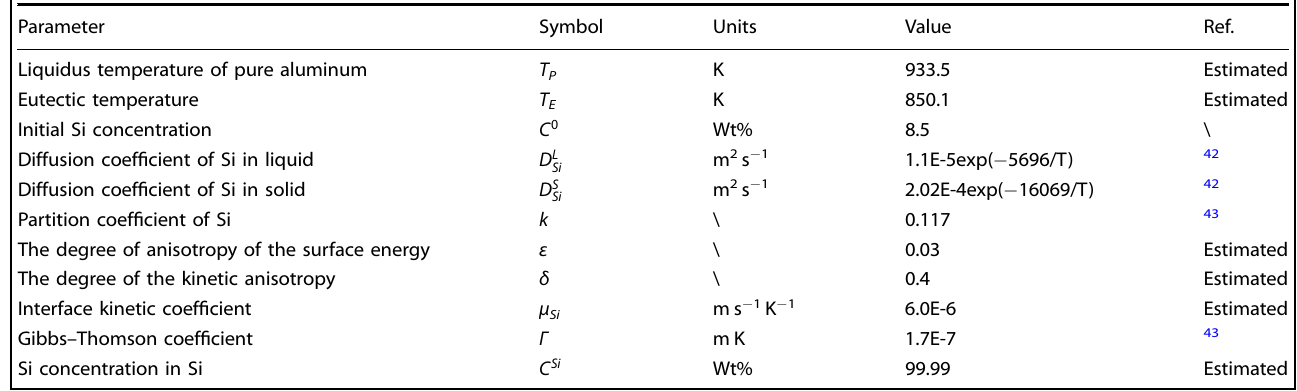
Table 1. Parameters used in this